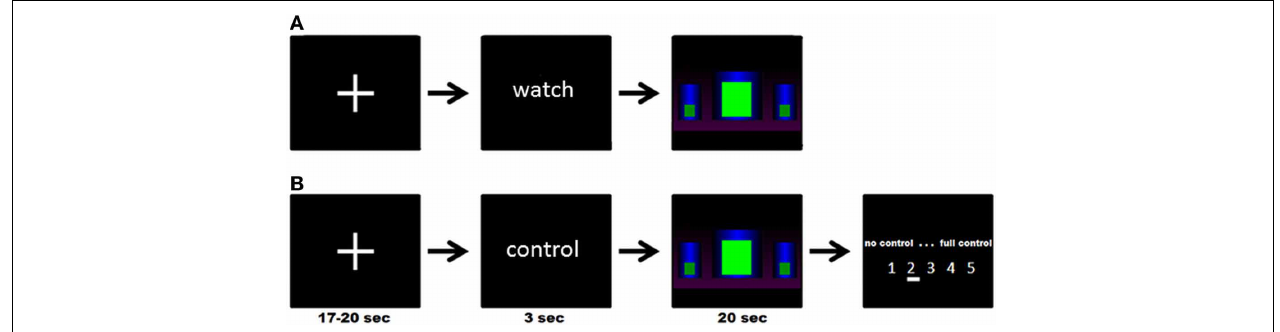
FIGURE 1 | (A) Example of a complete trial of the “watch moving/static bars” condition; (B) Example of a complete trial of the “get control” condition; participants were instructed to try to control the movements of the bars during functional MRI